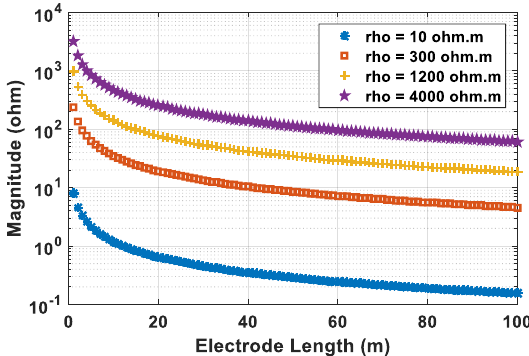
Figure 11. Grounding system effective length.